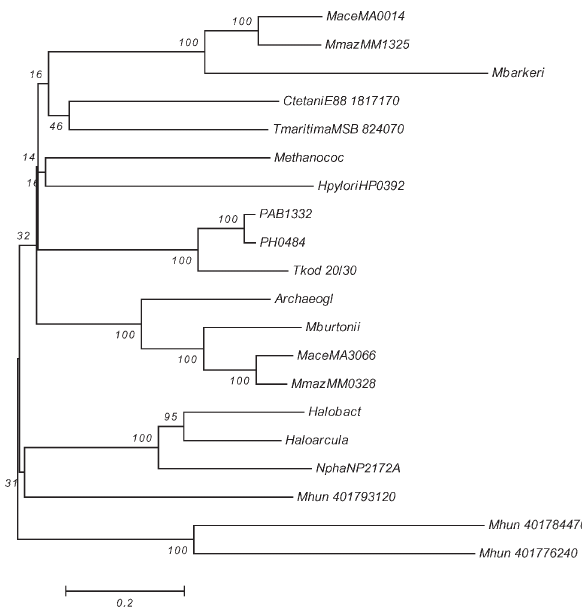
ments made by ClustalW (data not shown), but the results were not found to differ significantly. Figure 1 contains the ORFs